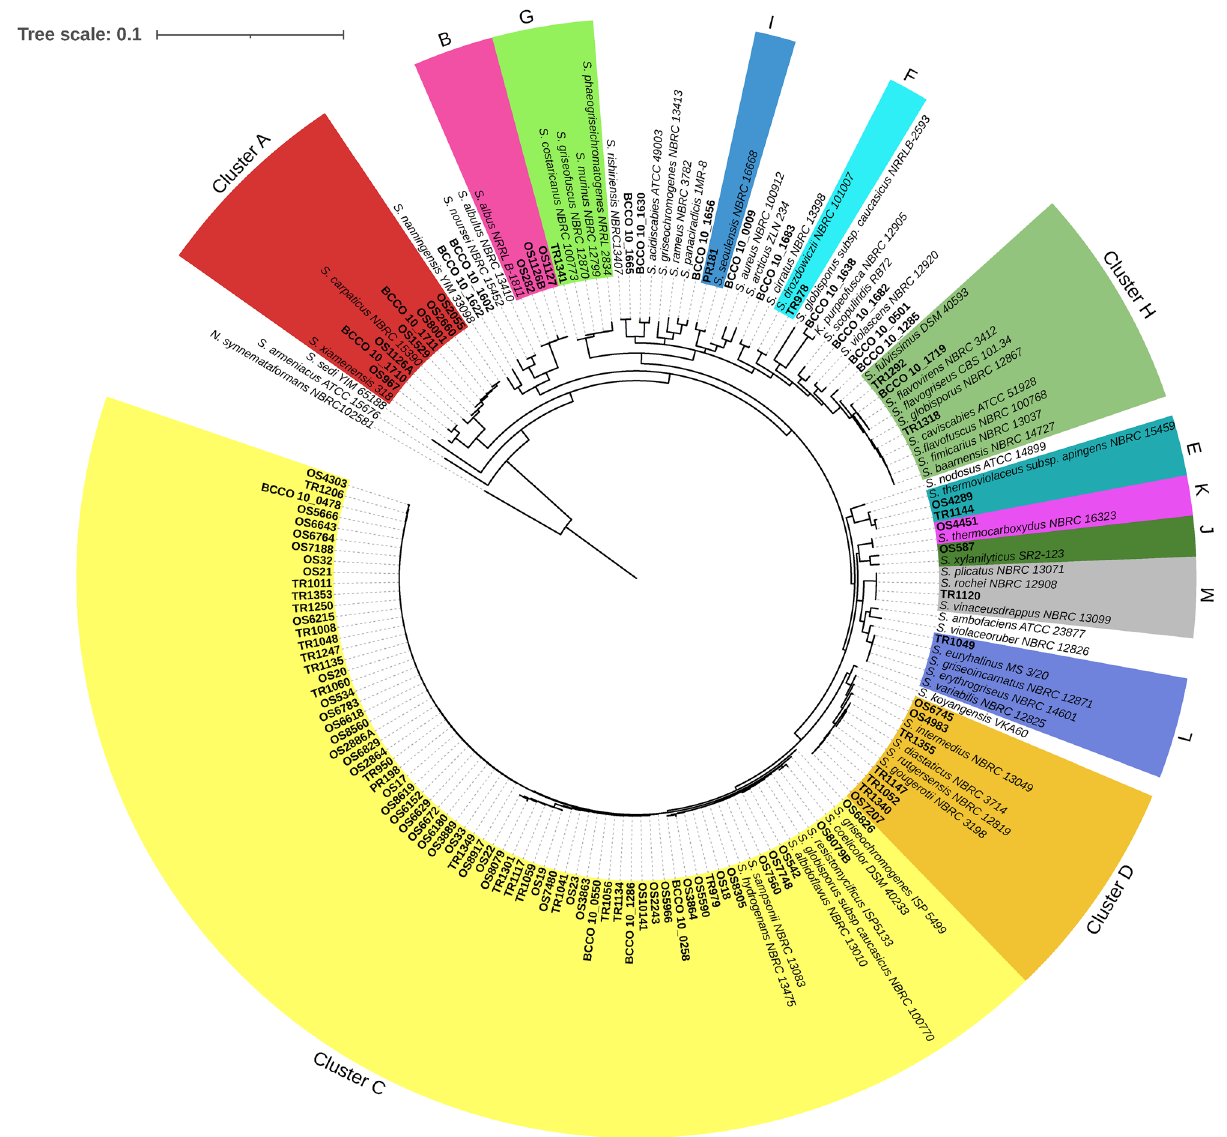
Figure 1. Neighbor-Joining tree of Streptomyces strains used in this study based on the 16S rRNA gene. Clinical isolates are highlighted in bold. Individual phylogenetic clusters are distinguished by colour and assigned letter codes. The 16S rRNA gene sequence of Nocardioides synnemataformans NBRC102581 served as the